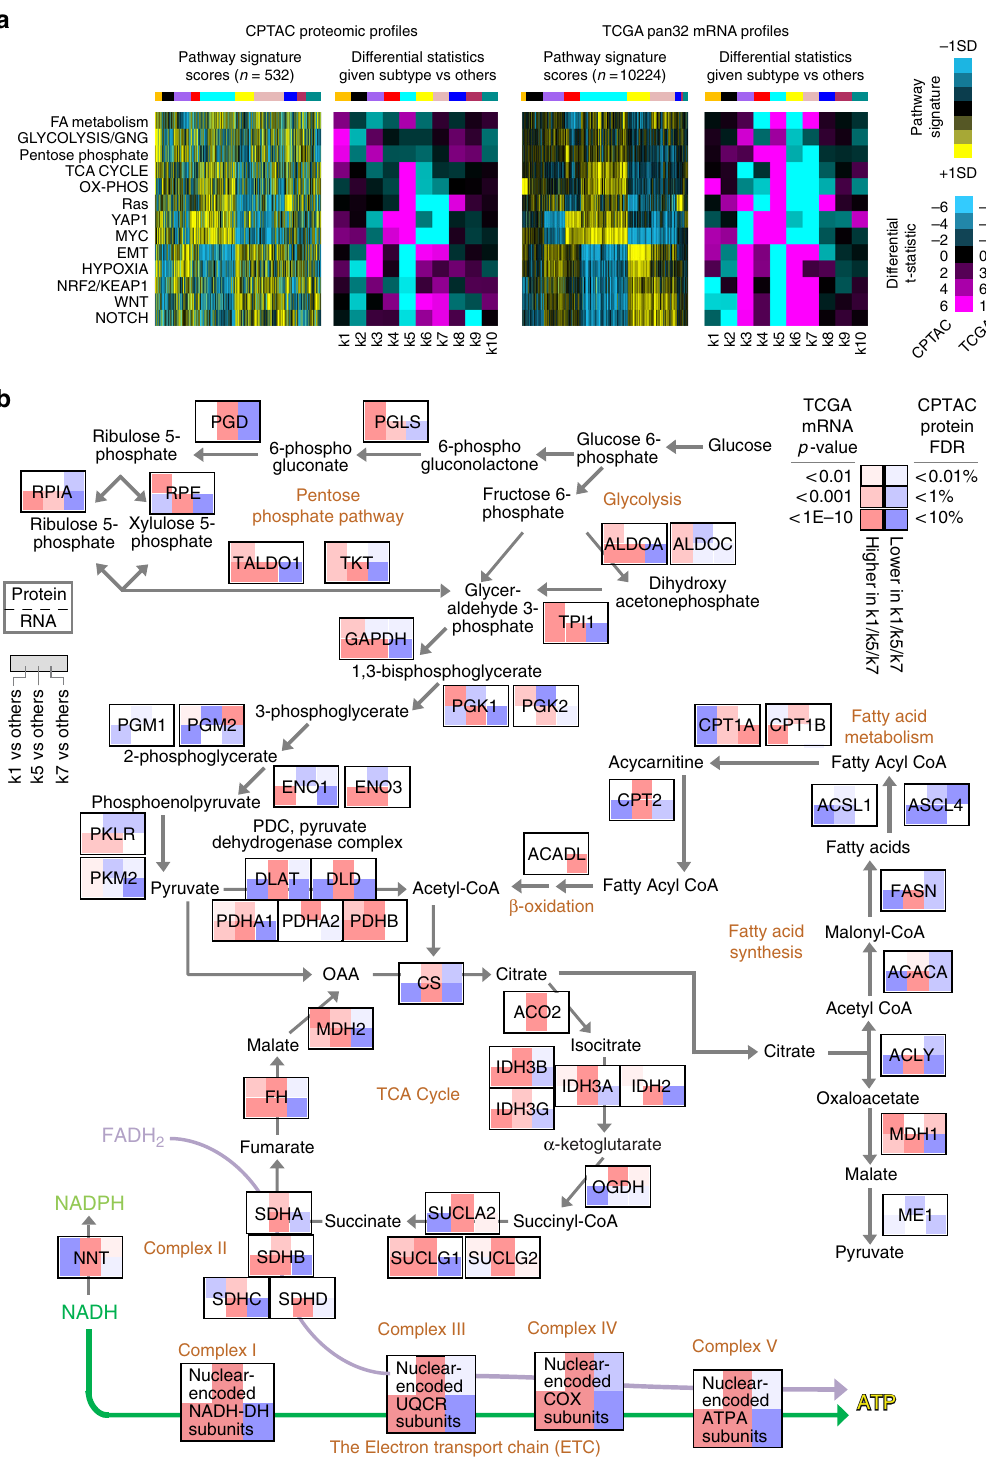
Fig. 4 Proteome-based subtype-speci fi c differences involving metabolic pathways. a For CPTAC Con fi rmatory/Discovery proteomic dataset and for TCGA pan32 mRNA dataset, pathway-associated gene signatures (using values normalized within each cancer type; SD, standard deviation from the median). For each dataset, purple-cyan heat maps denote t -statistics for comparing the given subtype versus the other tumors (bright purple/cyan, highly signi fi cant; black, not signi fi cant; shades close to black, borderline signi fi cant). Selected pathways surveyed by signatures 2 included several related to metabolism (FA fatty acid; GNG gluconeogenesis; TCA tricarboxylic acid; OX-PHOS oxidative phosphorylation). b Pathway diagram representing core metabolic pathways, with differential expression patterns represented (using values normalized within cancer type), comparing tumors in pan-cancer subtypes k1, k5, or k7 with the rest of the tumors. For each protein represented, the top portion represents results from differential protein analysis (CPTAC Con fi rmatory/Discovery proteomic dataset) and the bottom portion represents results from differential mRNA analysis (TCGA pan32 mRNA dataset). Red denotes signi fi cantly higher expression in k1/k6/k8 and blue denotes signi fi cantly lower expression. See also Supplementary Fig.